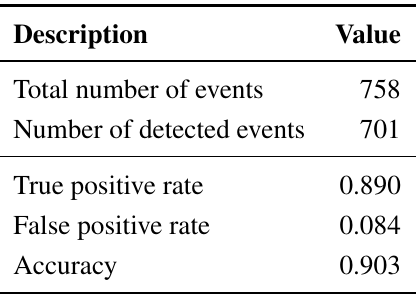
Table 7. Accuracy of the event detection algorithm.